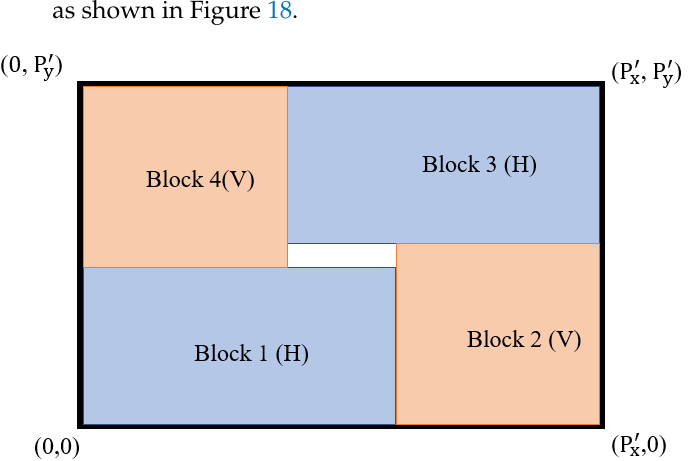
Table 2. Arrangement of each area.